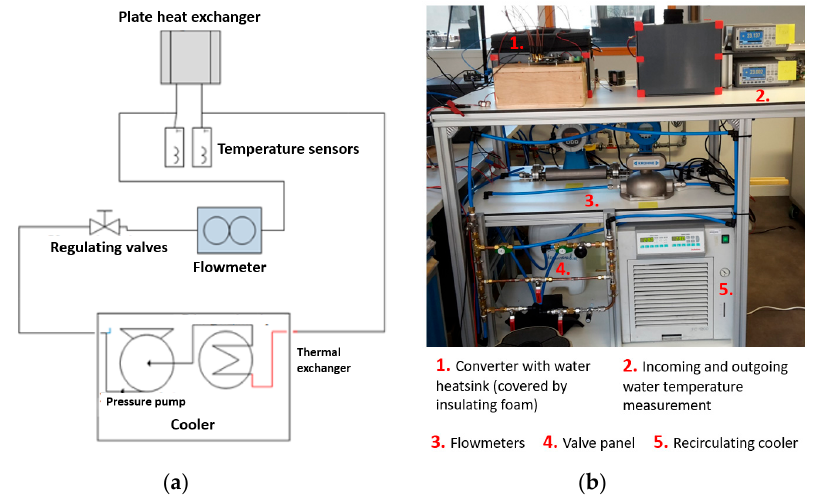
Figure 17. ( a ) Schematic and ( b ) picture of the semi-conductor loss measurement bench.